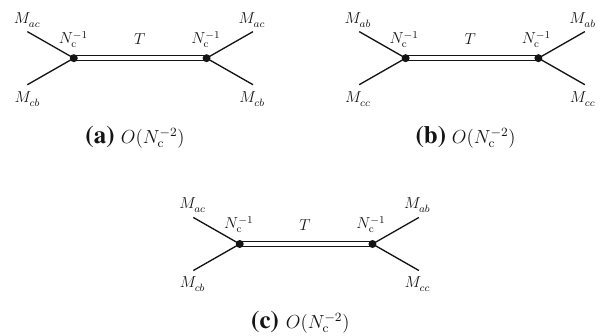
Fig. 15 Mixings, in the direct channel I, of a single-meson state with two-meson ( a ) and tetraquark ( b ) states. The flavor of the internal loop quark is designated by d and the corresponding tetraquark by T (cid:7)